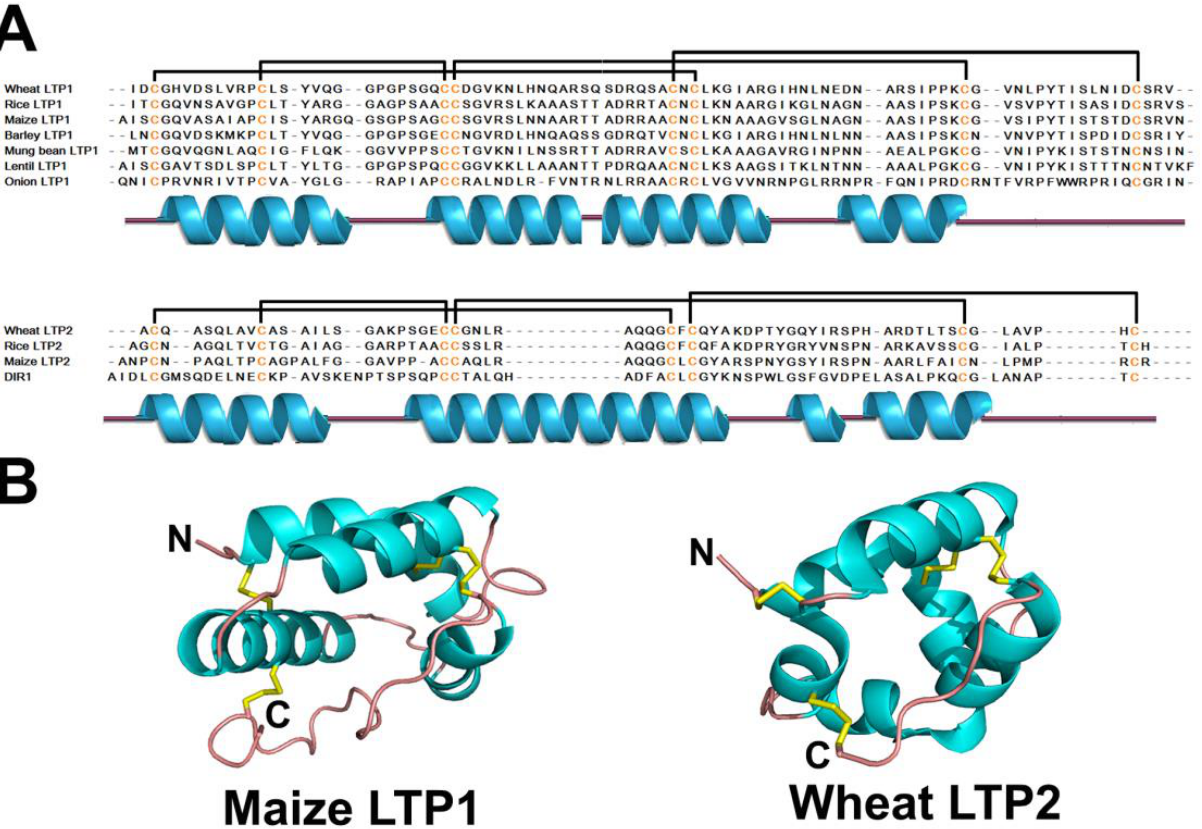
Figure 8. Sequences ( A ) and structures ( B ) of representative lipid transfer proteins. The secondary structure is represented by different colors: cyan-α helix; pink-random coil and yellow-disulfide